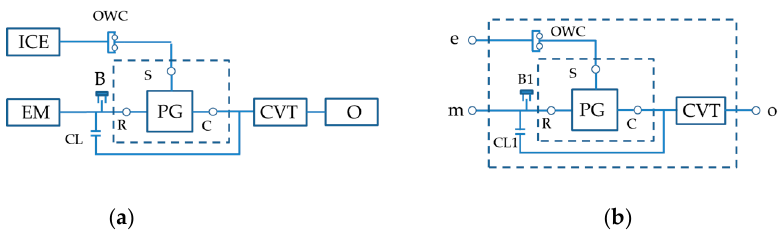
Figure 11. Type-b typical architecture: ( a ) Arrizo 7e; ( b ) Three-port diagram. (OWC—one way clutch).